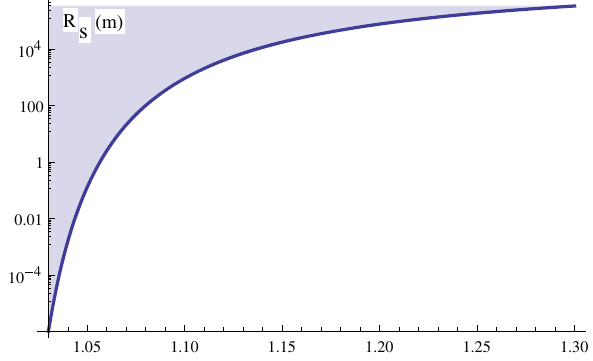
Fig. 1 Lowerboundon R s ,thecharacteristiclengthofthescalarunpar- ticle sector, in meters, as a function of the scale dimension, d U , where we considered the relative error in actual measurements of the Casimir effect in the Earth gravitational field, as being of the order of δ (cid:19) = 1%. The shadowed region embraces the possible values of d U and R s